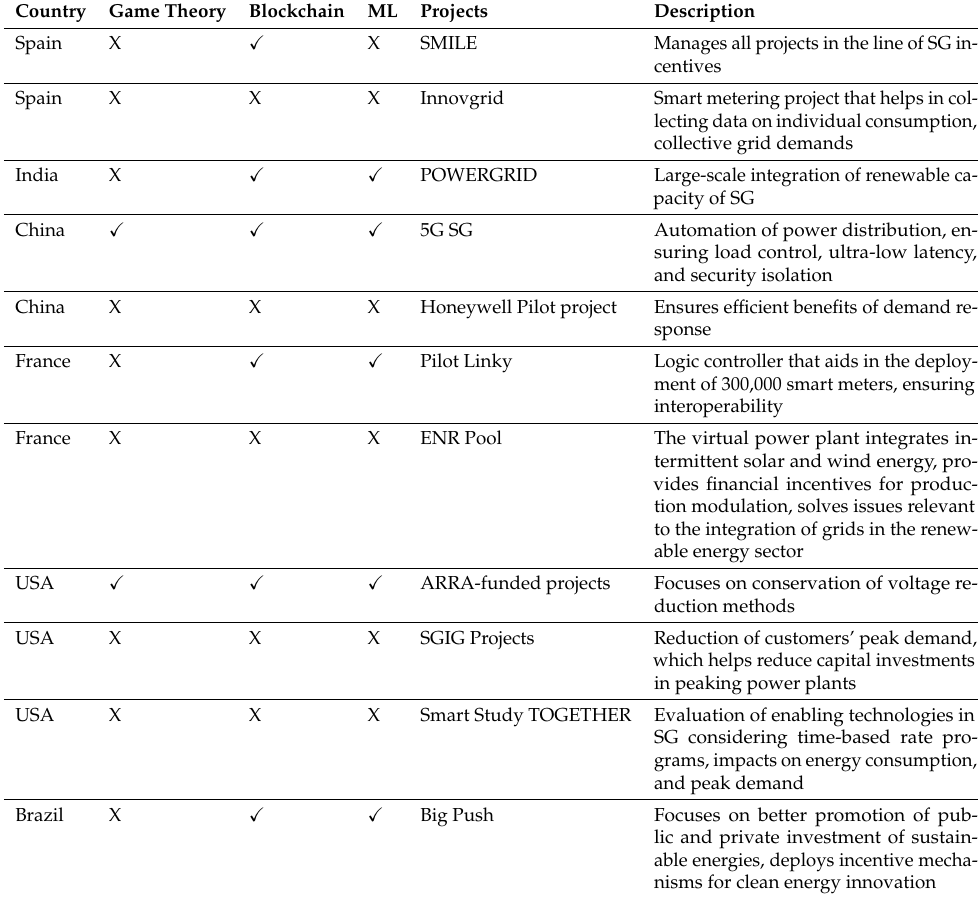
Table 4. Incentive-mechanism-based projects in various regions across the